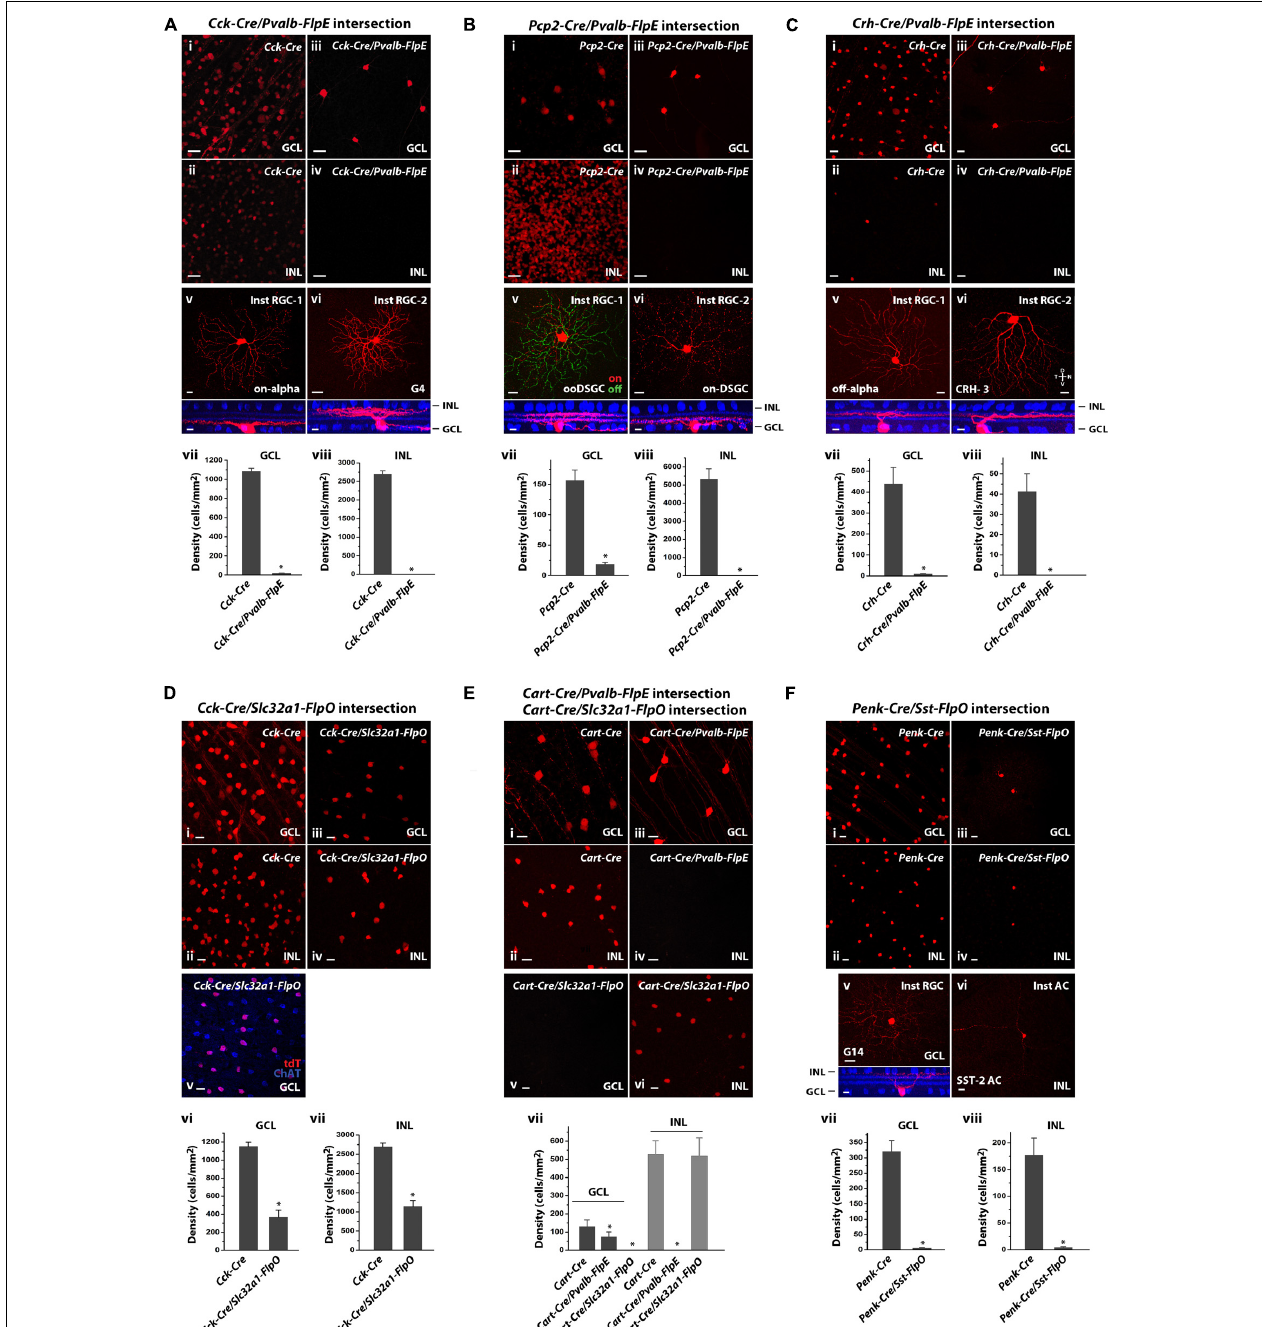
FIGURE 6 | Intersectional strategies to restrict labeling of retinal cell subpopulations. (A) Cck-Cre driver alone and in intersection with the Pvalb-FlpE driver. (i,ii) Distribution of tdTomato-labeled cells in the GCL (i) and the INL (ii) in the Cck-Cre driver crossed with the Ai9 reporter line. (iii,iv) Distribution of tdTomato-labeled cells from the Cck-Cre;Pvalb-FlpE;Ai65 intersection. (v,vi) Examples of individual cell types within the Cck/Pvalb intersection. Flat-mount view (top) and side view (bottom) with ChAT (blue). (vii,viii) Cell labeling density in the Cck-Cre and the Cck-Cre/Pvalb-FlpE intersection for the GCL (vii) or the INL (viii) . n = 6 retinas from 6 animals (4 litters) for the Cck-Cre;Ai9. n = 6 retinas from 6 animals (5 litters) for the Cck-Cre;Pvalb-FlpE;Ai65. ∗ p < 0.05, two-tailed t -test. (B) Pcp2-Cre driver alone and in intersection with the Pvalb-FlpE driver. (i,ii) labeling of Pcp2-Cre mice by crossing with the Ai9 reporter. (iii,iv) Intersection of Pcp2-Cre and Pvalb-FlpE in the Ai65 reporter. (v,vi) Flat mount views (top) and side views (bottom) of the cell types within the Pcp2/Pvalb intersection. (vii,viii) Cell labeling density in the Pcp2-Cre and the Pcp2-Cre/Pvalb-FlpE intersection for the GCL (vii) or the INL (viii) . n = 6 retinas from 6 animals (4 litters) for the Pcp2-Cre;Ai9. n = 6 retinas from 6 animals (6 litters) for the Pcp2-Cre;Pvalb-FlpE;Ai65 . ∗ p < 0.05, two-tailed t -test. (C) Crh-Cre driver alone and in intersection with the Pvalb-FlpE driver. (i,ii) Crh-Cre driver expression as reported by Ai9 mice. (iii,iv) Intersection of Crh-Cre and Pvalb-FlpE in the Ai65 reporter. (v,vi) Example images of flat mount views (top) and side views